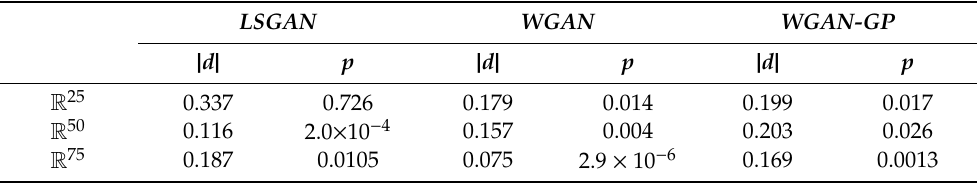
Table 3. Best obtained absolute difference and p value calculations for robust equivalency testing of Table 4. Best obtained absolute di ff erence and p value calculations for robust equivalency testing. each of the synthesized distributions using different GANs. Values calculated comparing the original target distribution (DS1) with synthetic data generated by di ff erent GANs with di ff erent sized latent vectors as generator input. LSGAN WGAN